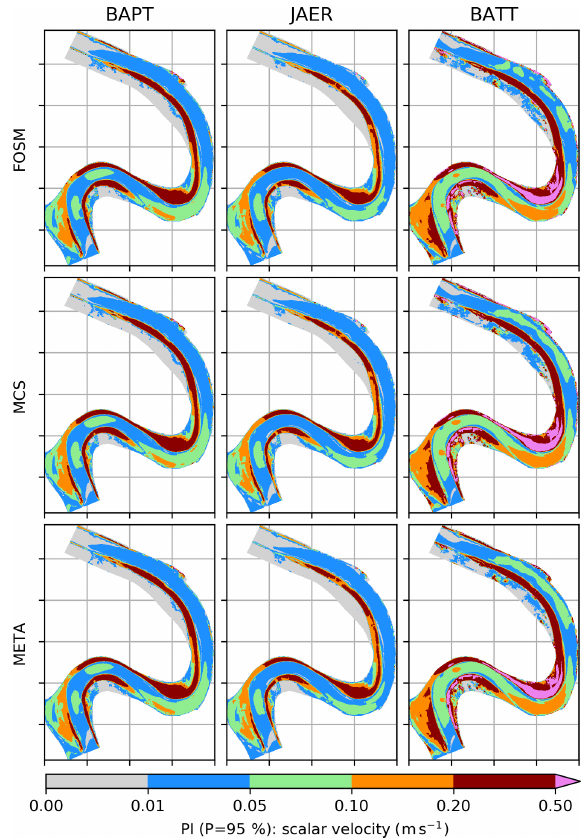
Figure 5. Prediction interval of flow velocity under submerged con- ditions (rows: friction formulations; columns: UQ methods).